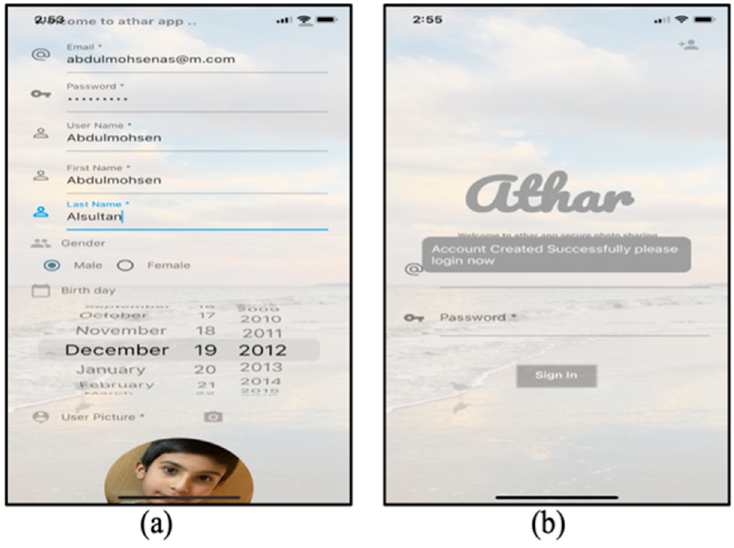
Figure A3. Registration process: ( a ) refers to sign up page, while ( b ) refers to sign in page.